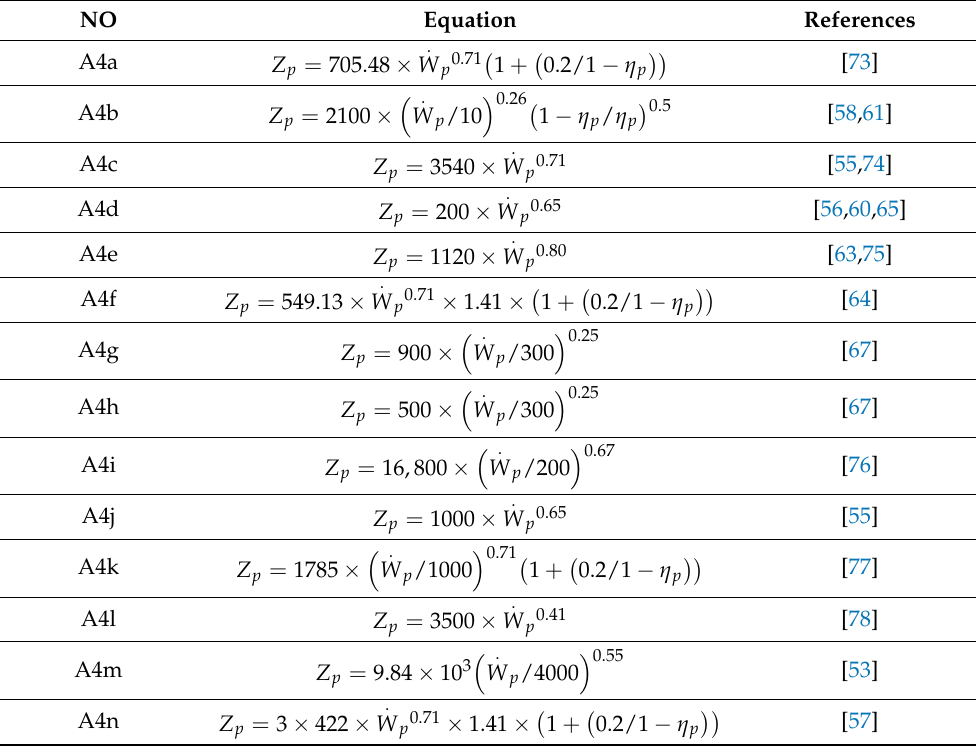
Table A4. Pump purchasing cost